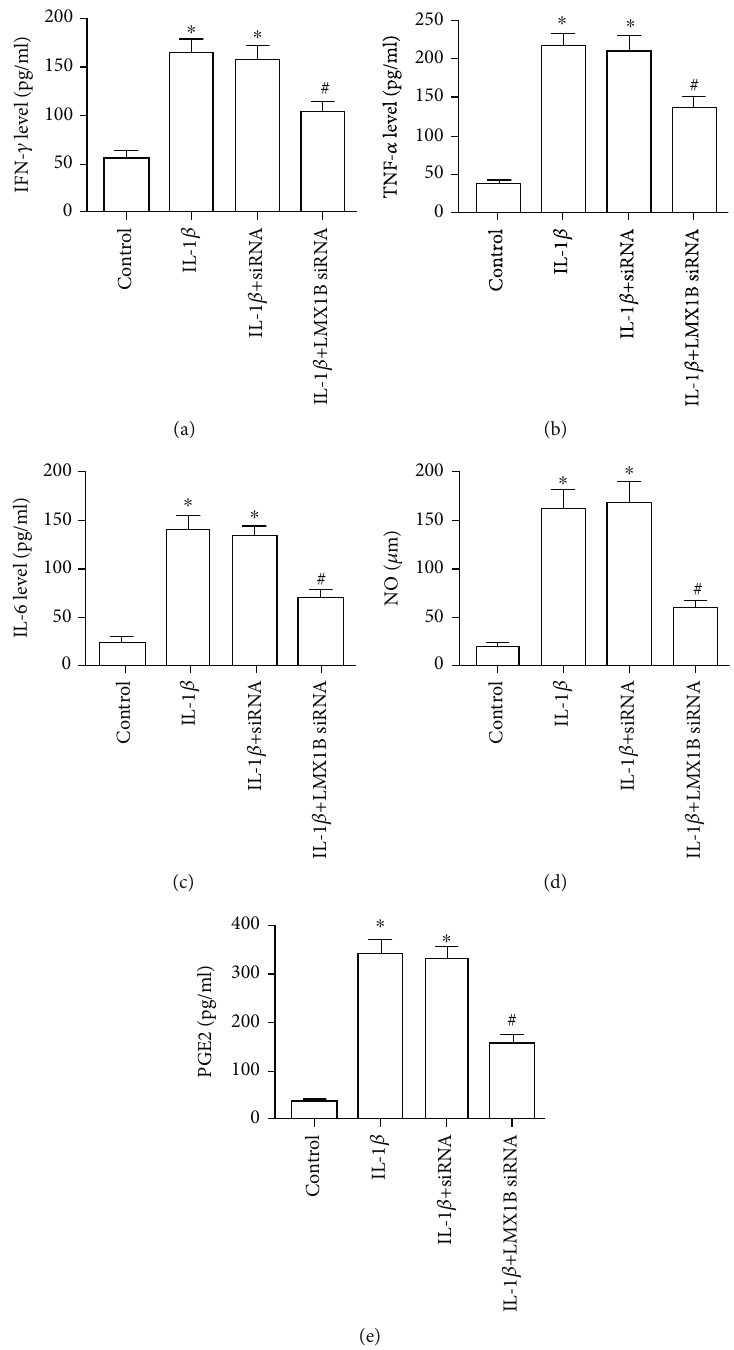
Figure 5: LMX1B depletion suppressed IL-1 β -induced in fl ammatory cytokines secretion in C28/I2 cells. ELISA kits were used to determine the expression of IFN- γ (a), TNF- α (b), IL-6 (c), and PGE2 (d); (e) NO concentration was determined by the Griess reaction. C28/I2 cells were transfected with control siRNA or LMX1B siRNA for 24h by using Lipofectamine 2000 reagent and then treated with 10 ng/ml IL-1 β for 24h. ∗ P < 0 : 05 , compared with the control group; # P < 0 : 05 , compared with the IL-1 β group. All experiments were repeated three